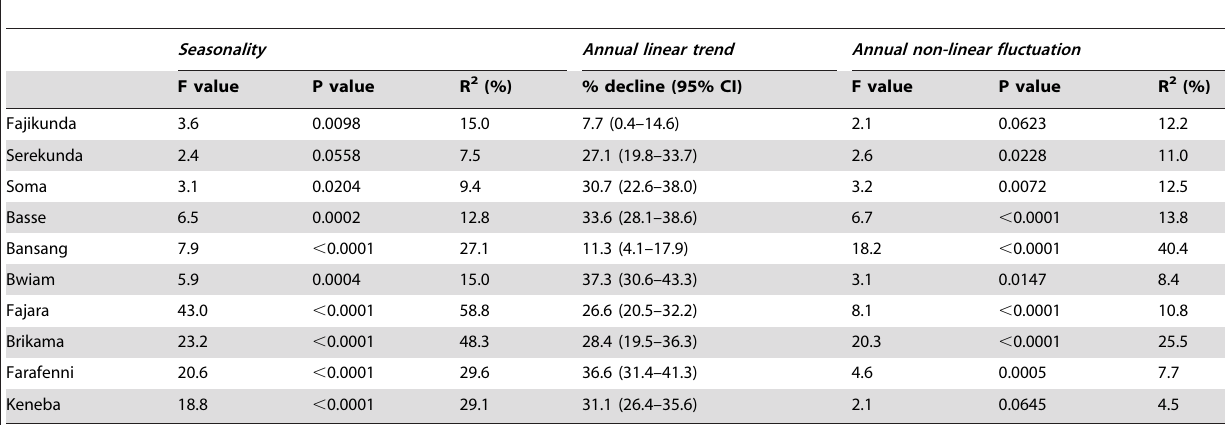
Table 1. Modelling of seasonality and average annual decline in numbers of malaria positive slides at each of the 10 health facilities studied in The